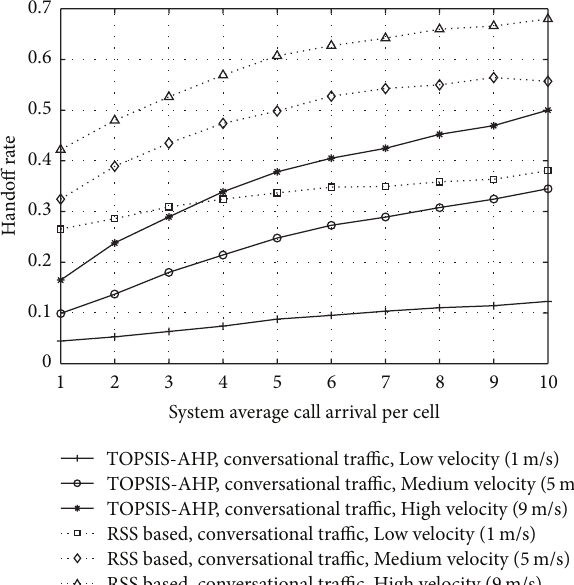
Figure 8: Handoff rate using TOPSIS-AHP.